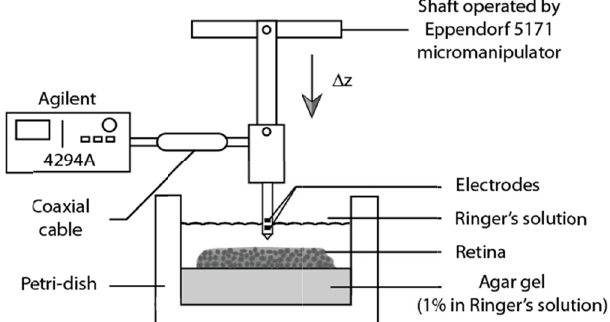
Fig. 5: Experimental apparatus 5171 micromanipulator that displaces the (zaxis) in steps of 10m, (ii) an Agilent 4294A impedance analyser for recording impedance/phase spectra for each probed retinal depth. ( retinal slice placed on a block of Agar gel (1% in Ringer’s solution) submerged in Ringer’s